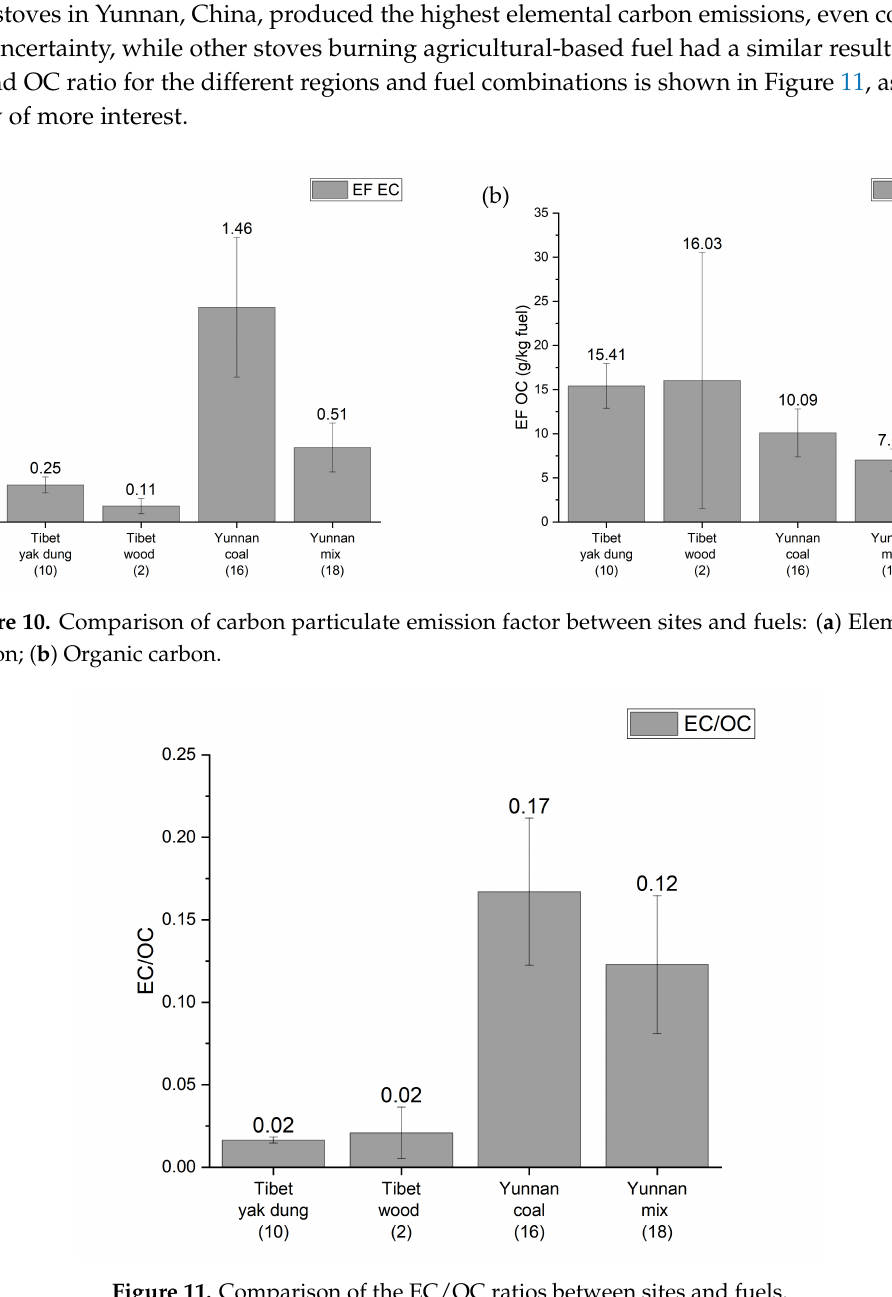
Figure 11. Comparison of the EC/OC ratios between sites and